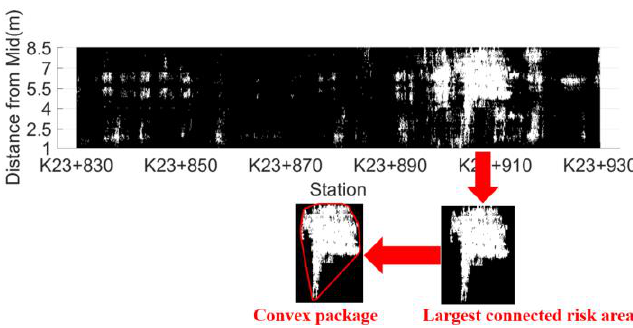
Figure 8. Regional distribution of segregation risk areas.